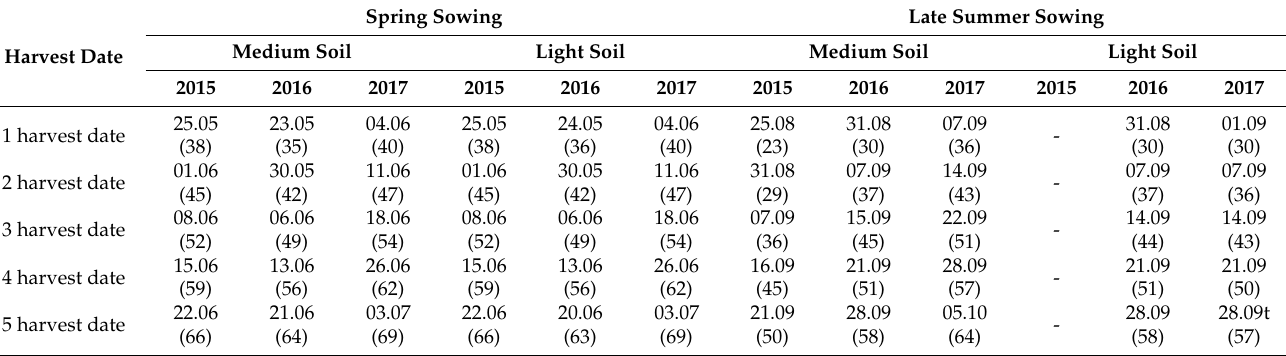
Table 1. Quinoa harvest date and number of days from sowing to harvest (in